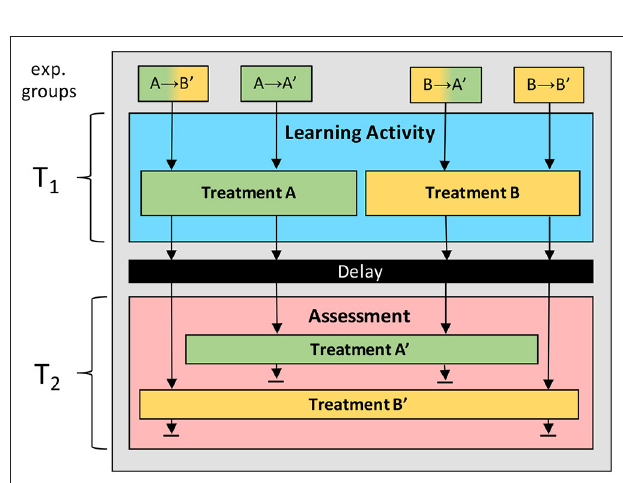
FIGURE 2 | Illustration of the Double Treatment experimental design. Both the learning activity and the assessment are subject to identical or homologous experimental treatments A and A ′ , as well as B and B ′